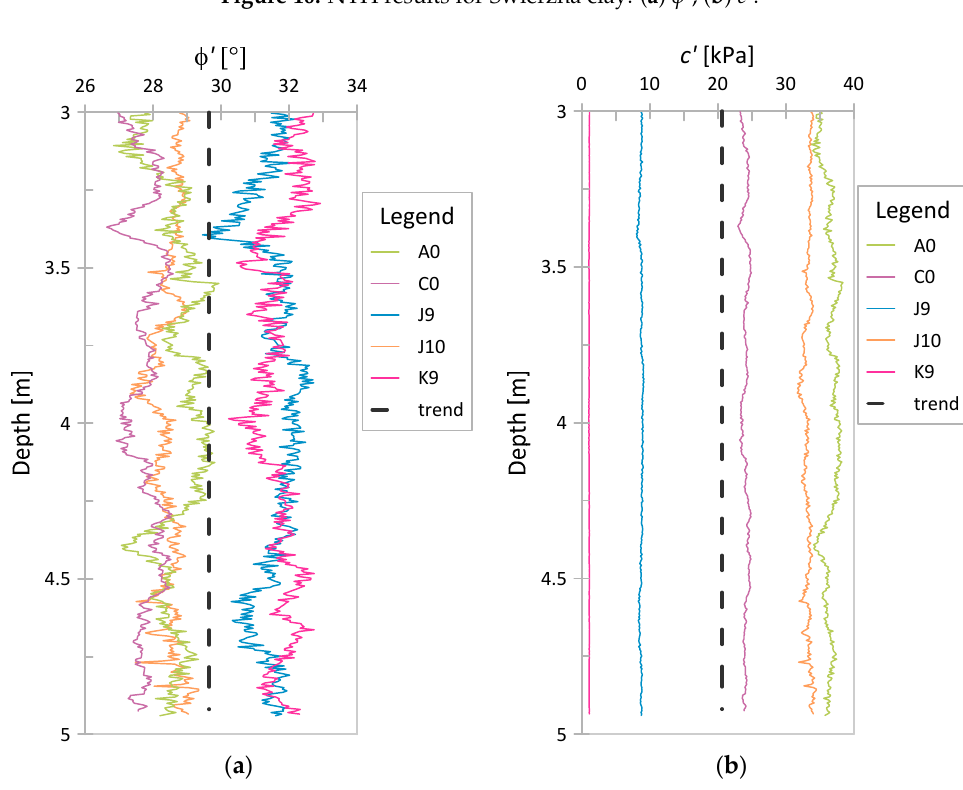
Figure 10. NTH results for Ś wierzna clay: ( a ) ϕ ′ ; ( b ) c ′ .